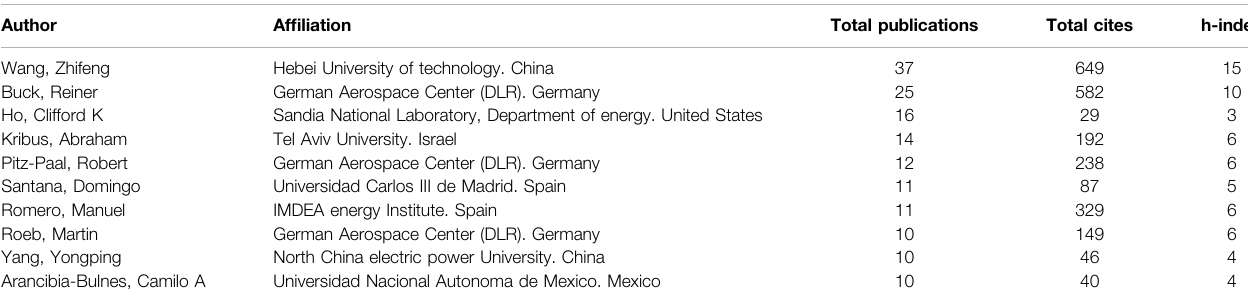
TABLE 11 | Top 10 authors in Solar Tower fi eld. Author